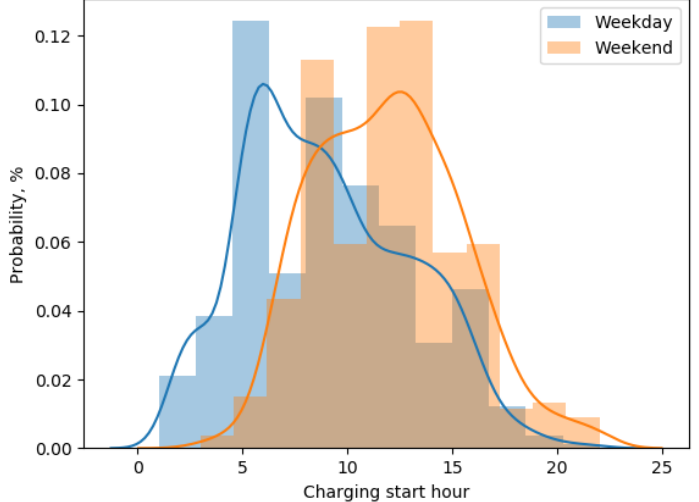
Figure 2. Distribution of the charging start hour for weekdays and weekends in the dataset. Time set to